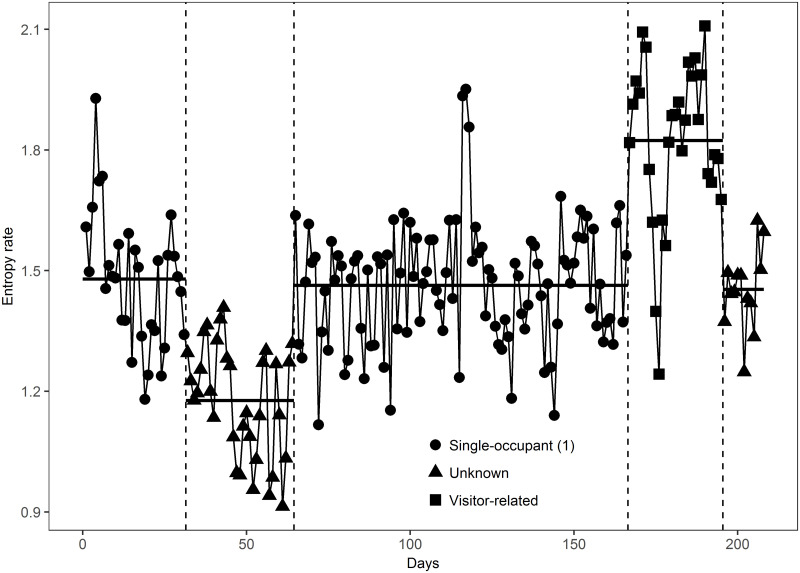
The daily entropy rates in five segments for House 55.The black horizontal lines in the graph show the sample means of the daily entropy rate for each segment, and the vertical dashed lines indicate the location of four change-points.